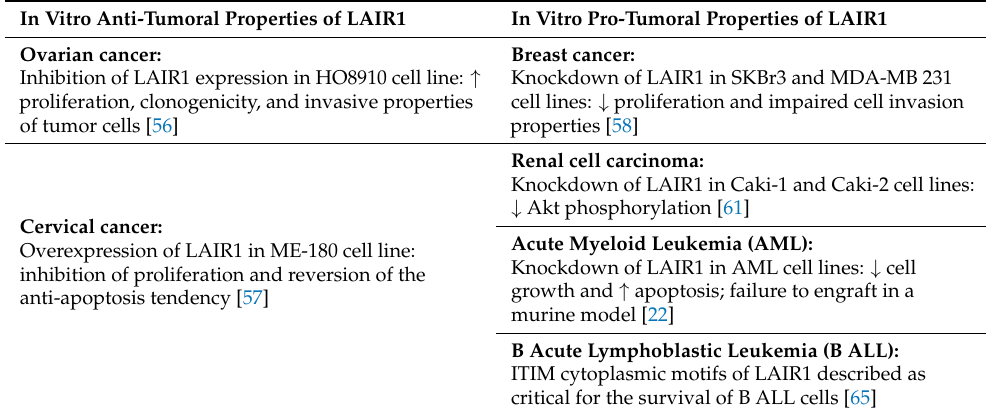
Table 2. Opposite effects of LAIR1 observed in vitro in several cancer cell lines ( ↑ : increase; ↓ : decrease). In Vitro Anti-Tumoral Properties of LAIR1 In Vitro Pro-Tumoral Properties of LAIR1 Ovarian cancer: Inhibition of LAIR1 expression in HO8910 cell line: